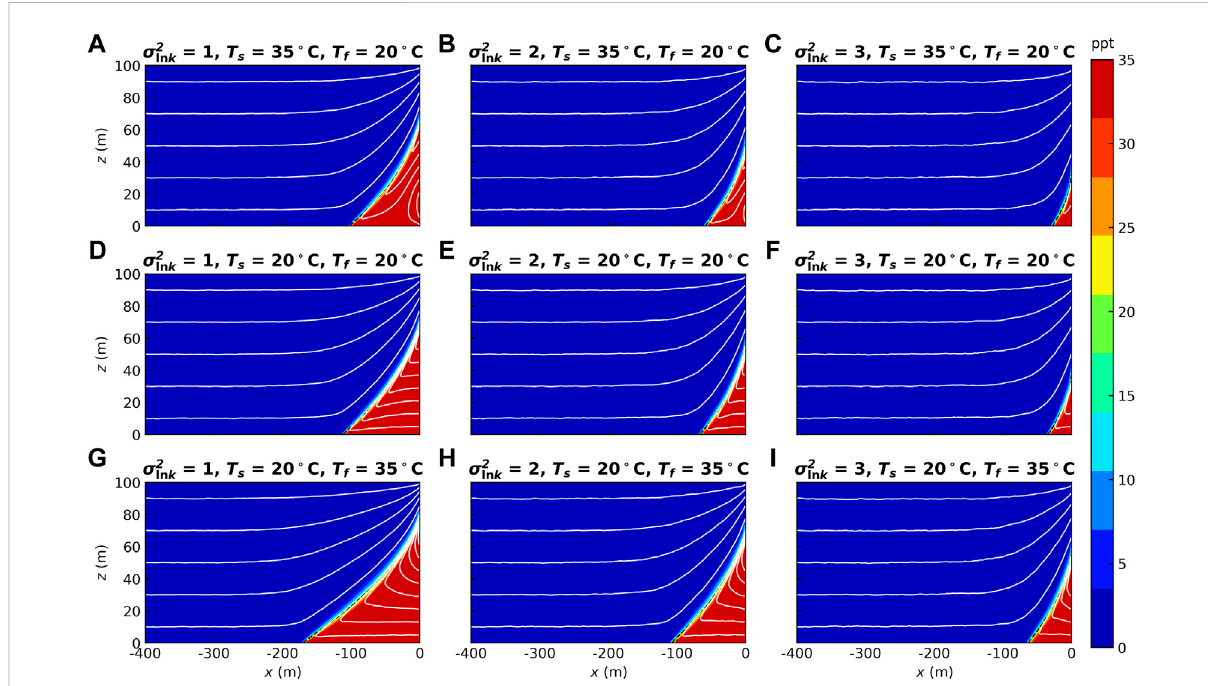
FIGURE 7 AveragedsalinitydistributionsinheterogeneousaquifersunderdifferentpermeabilityvariancesandFW-SWtemperaturecontrasts( n =50).The left-hand (A,D,G) ,middle (B,E,H) andright-hand (C,F,I) panelsaretheresultsfordifferentvariancesofrandompermeability fi elds( σ 2 ln k =1,2,and3, respectively). λ x is fi xed at 0.5 m. The black dashed lines are the 50% seawater concentration isohalines (17.5 ppt), i.e., the FSI. The white lines show fl ow streamlines. T s and T f are seawater and freshwater temperatures,